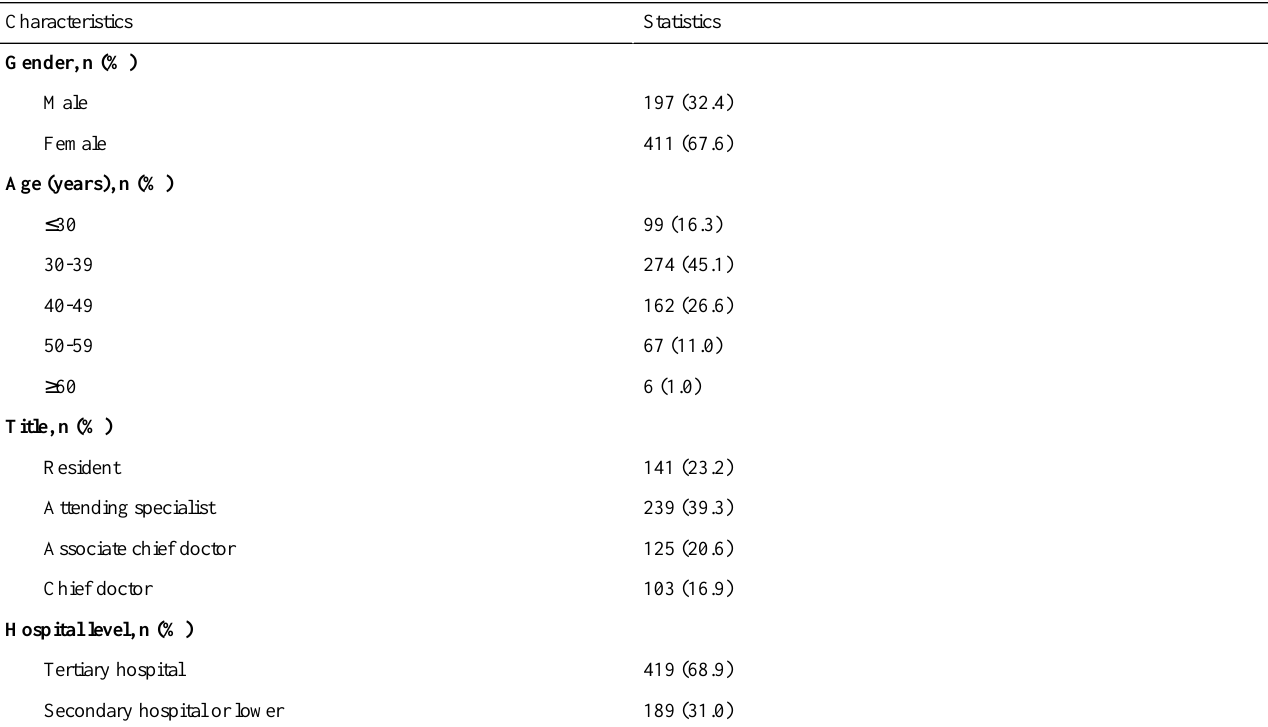
Table 5. Characteristics of the surveyed diabetologists